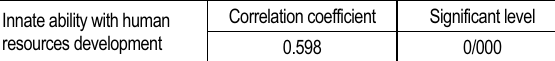
Table 6. Spearman correlation coefficient